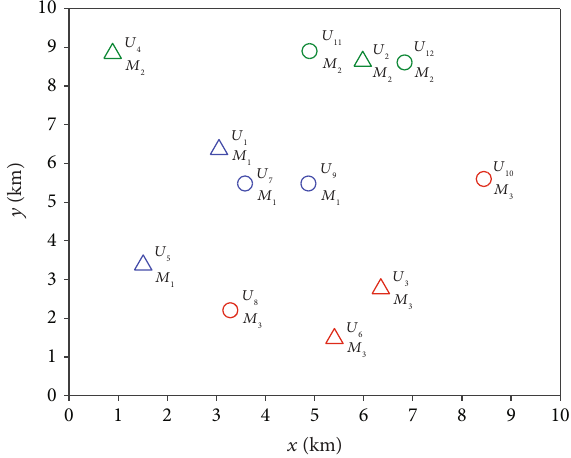
Figure 5: The clustering result obtained by the feature weight